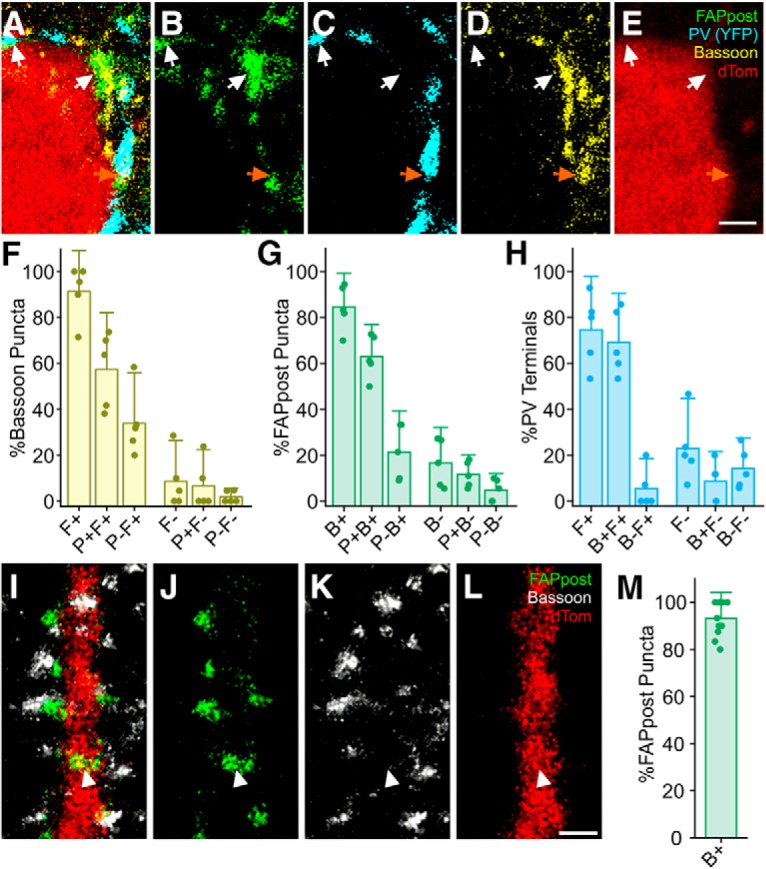
FAPpost puncta align with presynaptic bassoon. A, Optical section of a confocal image used to assess bassoon immunofluorescence alignment with PV terminals on soma of FAPpost-labeled cell visualized in Ai3xPV-Cre mouse. Quadruple channel overlay showing presynaptic PV terminal (YFP, cyan) colocalization with bassoon immunofluorescence (Alexa Fluor 405; yellow) and alignment with FAPpost puncta (green) on dTom (red) filled soma. Scale bar = 1 μm. B–E, As in A, but each channel in isolation. White arrows indicate triple-channel alignment example puncta, orange arrow indicates quadruple-channel alignment example puncta. F, Presynaptic bassoon puncta rate of alignment with FAPpost (F+) and/or colocalization with PV terminals (P+). Bars are mean ± SD of individual soma alignment rates (dots; n = 5 soma; puncta assessed, n = 104). G, FAPpost puncta rate of alignment with bassoon (B+) and/or PV terminals (P+; dots; n = 5 soma; puncta assessed, n = 92). H, PV terminal rate of alignment with FAPpost (F+) and colocalization with bassoon (B+, dots; n = 5 soma, terminals assessed, n = 83). I, Triple channel overlay showing presynaptic bassoon immunofluorescence (Alexa Fluor 405; white) alignment with dendritic FAPpost. Scale bar = 1 μm. J–L, As in I, but each channel in isolation. White arrowhead indicates FAPpost puncta not aligned with bassoon. M, FAPpost rate of alignment with bassoon (B+) along separate dendritic segments (dots; n = 11 dendritic segments; puncta assessed, n = 143).